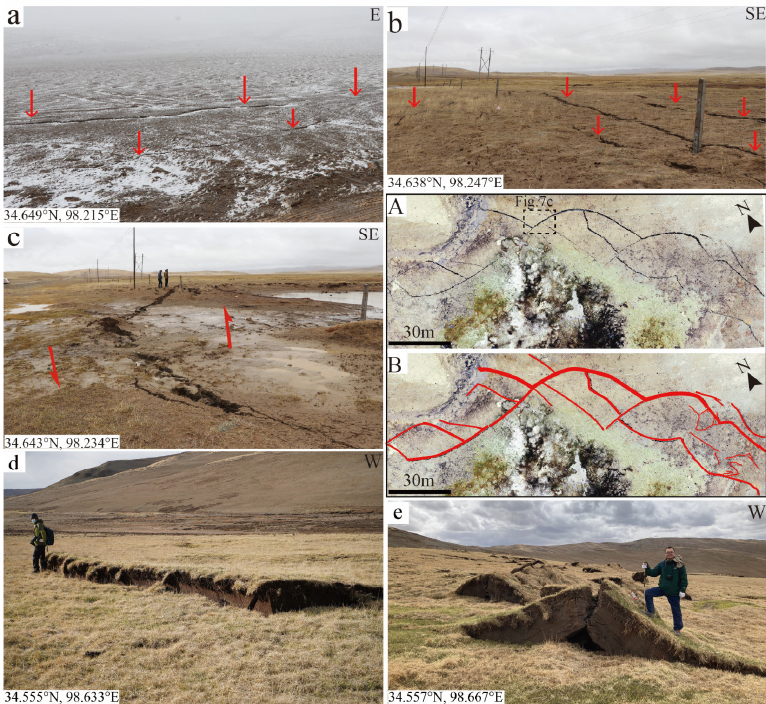
Figure 7. Surface rupture along the Huanghe town segment ( a – c , A , B ) and Dongcaoalong lake seg- ment ( d , e ); ( a – c ) multiple extensional cracks on the surface rupture; ( d ) partial compressional thrust scarp; ( e ) bilateral symmetrical mole tracks developed along the rupture. ( A , B ) Representative or- thophotos of rupture showing shear extensional